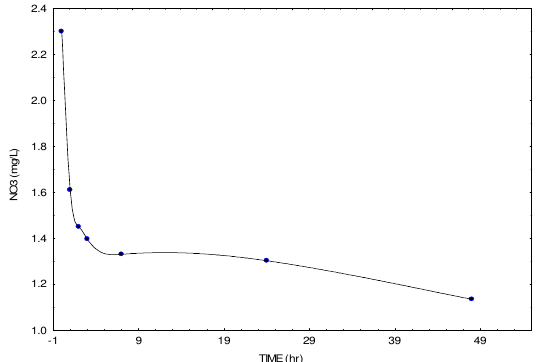
Fig. 3. NO 3 Pollutant concentration with time at T = 25 o C, pH 7, wastewater/(Algae broth) ratio = 1, and sterilized wastewater.